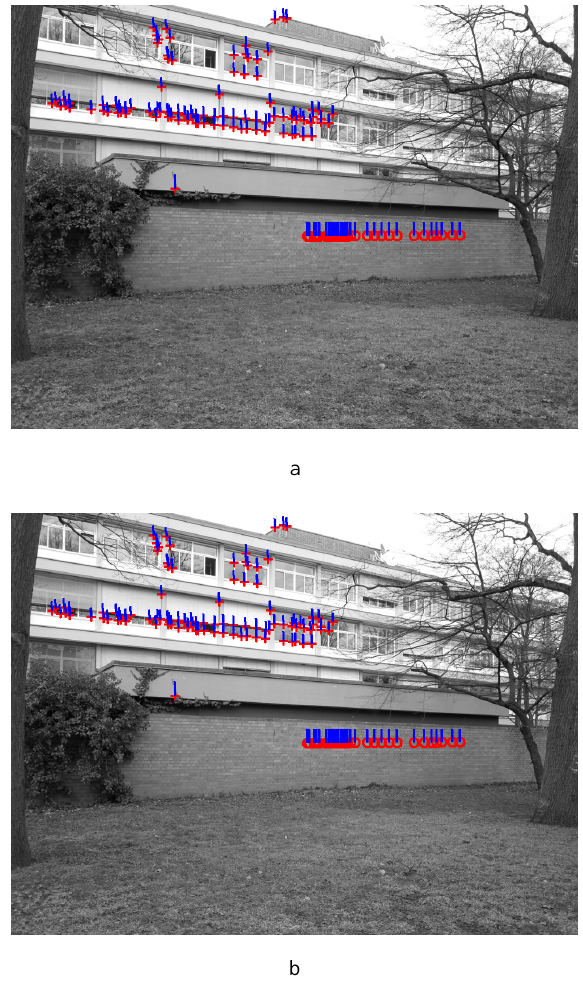
Figure 4. The second (a) and the fourth image (b) with marked image features (red crosses), projected laser points (red circles), and their tracks (blue